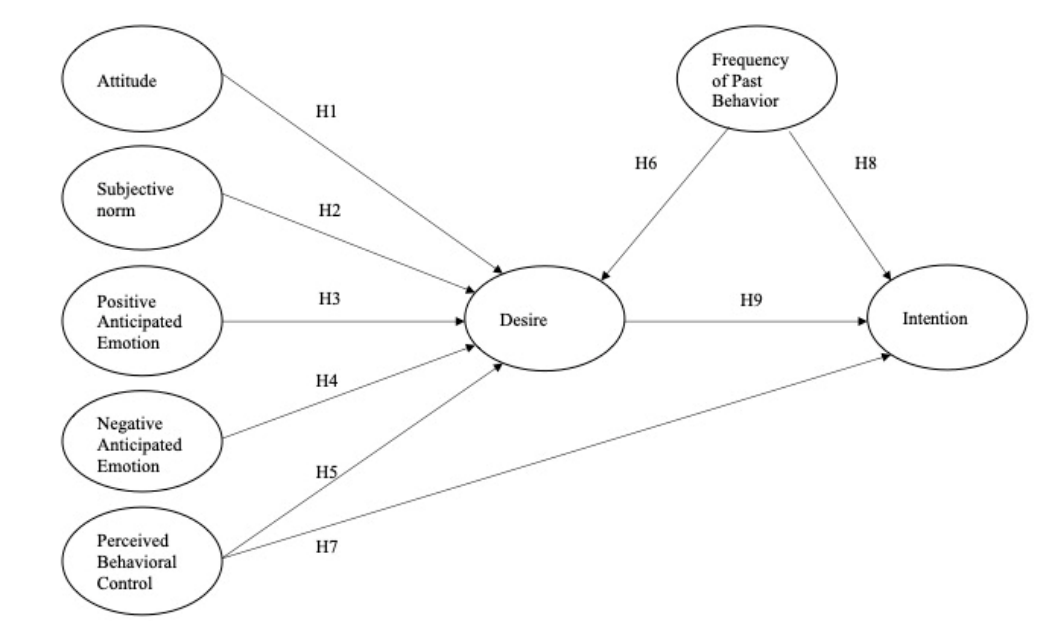
Figure 1. The conceptual model with study hypotheses.